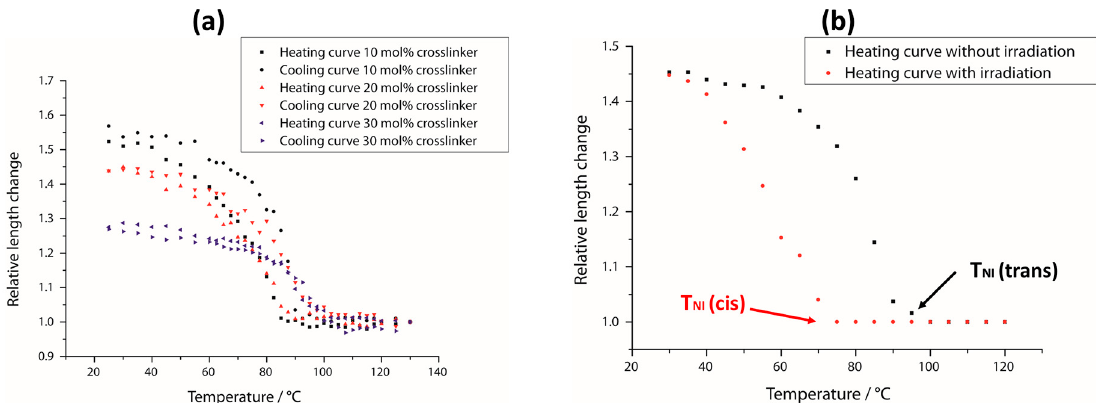
Figure 6. Thermoresponsive behavior of this LCE system. ( a ) Heating and cooling curves for three films with different crosslinker concentrations, respectively; ( b ) heating curve for an LCE film with and without irradiation. Here, T NI ( trans ) is the phase transition temperature of the film’s all- trans state and T NI ( cis ) the one for its photostationary state under irradiation.